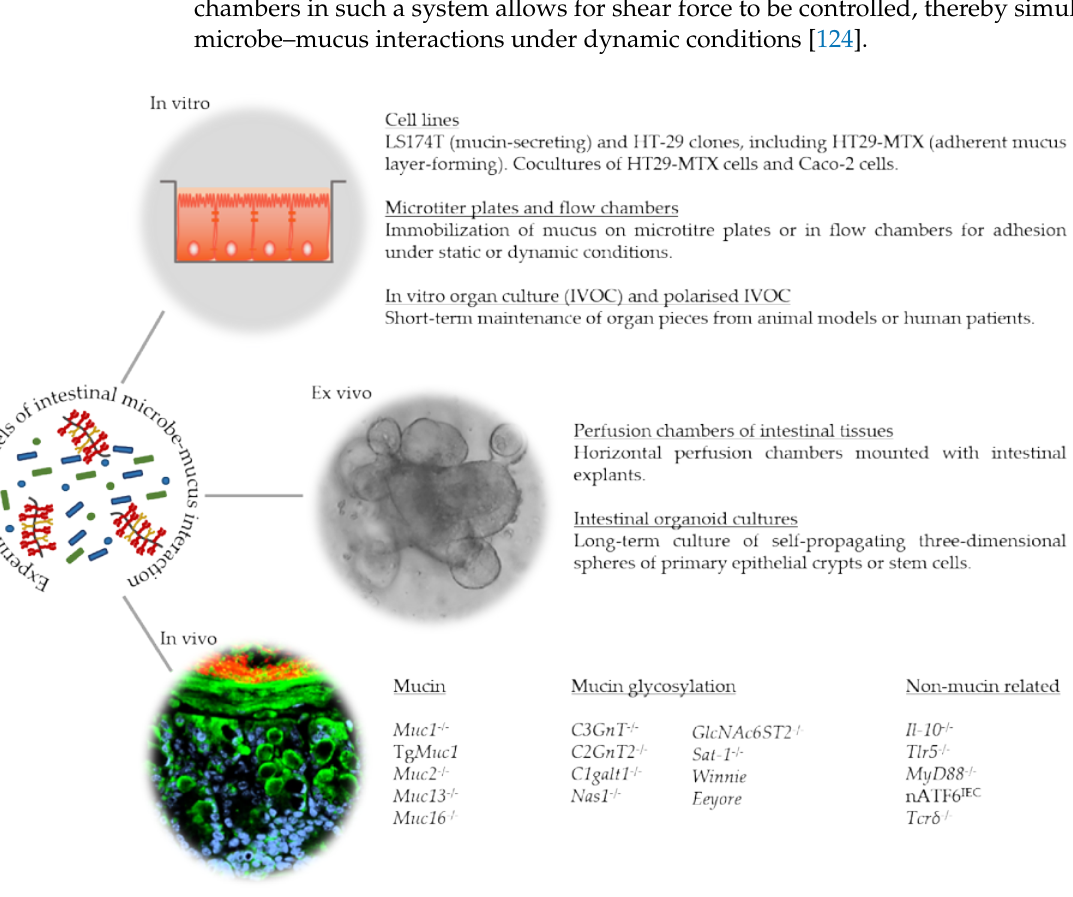
Figure 2. Examples of experimental models of intestinal microbe–mucus interactions. Mucus-secreting and mucus layer- forming cell lines, in vitro organ culture (IVOC) and polarized IVOC, as well as microtiter plates and flow chambers serve as useful models to apply in vitro. The long-term culture of intestinal organoids and short-term culture of intestinal explants in perfusion chambers present two ex vivo models. Listed are mucin, mucin glycosylation, and non-mucin-related rodent models that display alterations in the mucus layer, providing useful in vivo